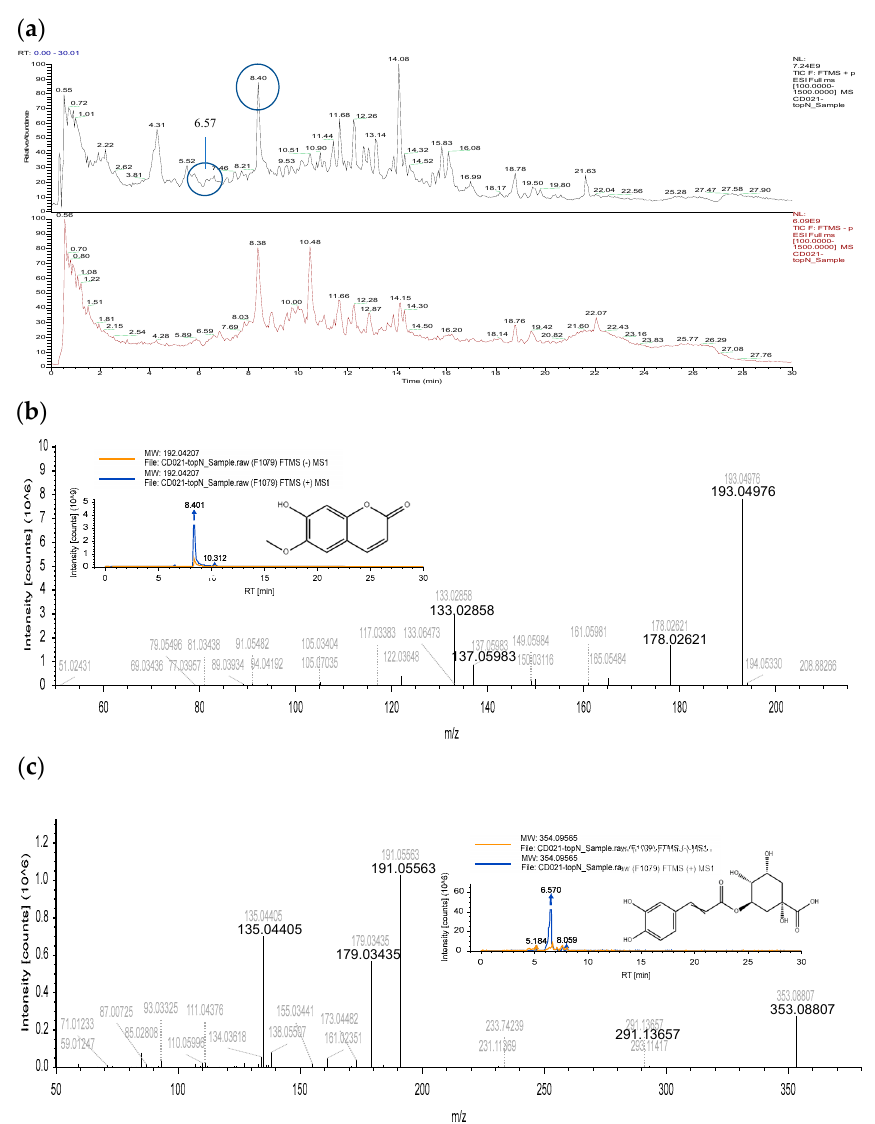
Figure 1. The total ion chromatograms of the SCHE ( a ) as well as the mass spectrometry of scopoletin ( b ) and chlorogenic acid ( c ).